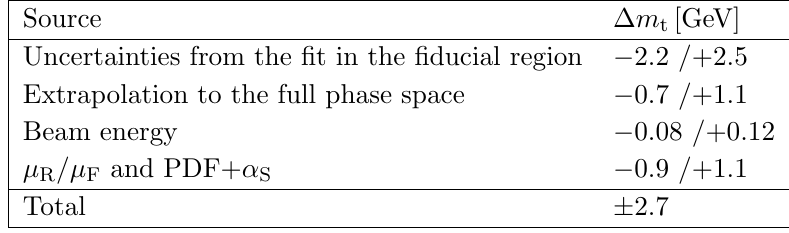
Table 1 . The source and value of the systematic uncertainties in the measurement of m t . where the last factor ( A=A ( m )), is a mass-dependent correction to the acceptance. Using t simulated tt samples with di(cid:11)erent m , we (cid:12)nd that the acceptance changes by 0.08% per t (cid:1) m = 1 t